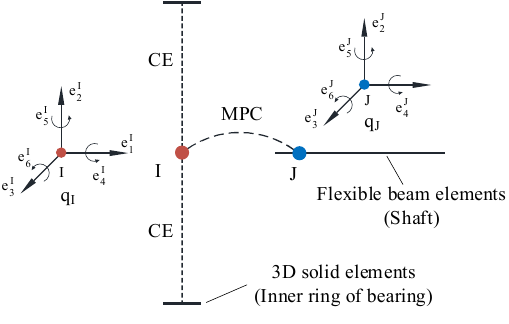
Figure 6. Shaft-bearing coupling diagram.